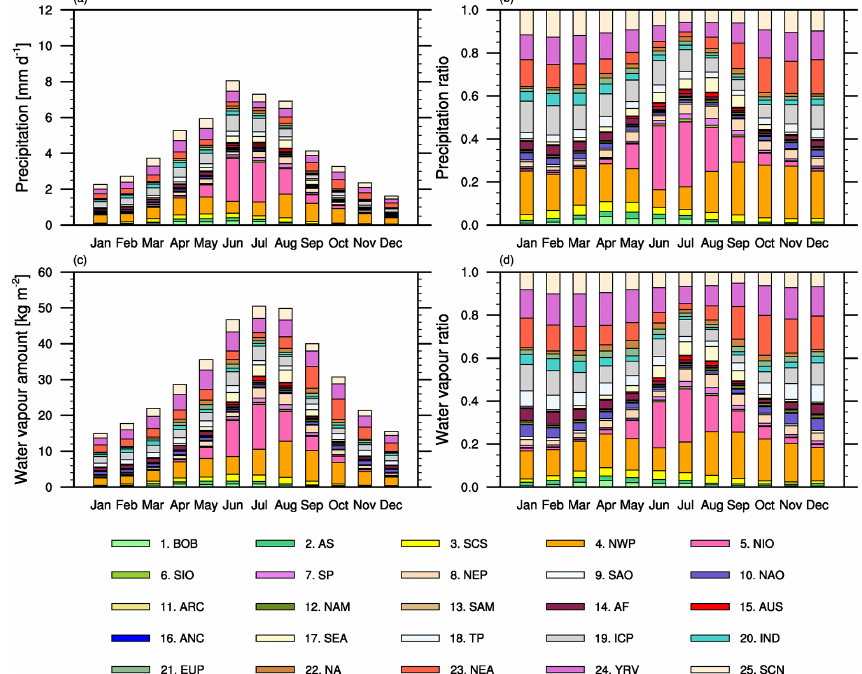
Figure 6. (a) Monthly averaged evaporative contributions of 25 defined source regions to the precipitation over the YRV. (b) Same as (a) , but for the relative contribution to precipitation. (c) Monthly averaged evaporative contributions of 25 defined source regions to the tropospheric total water vapour amount over the YRV. (d) Same as (c) , but for the relative contribution to water vapour. Stacked column colours correspond to source region colours in Fig.